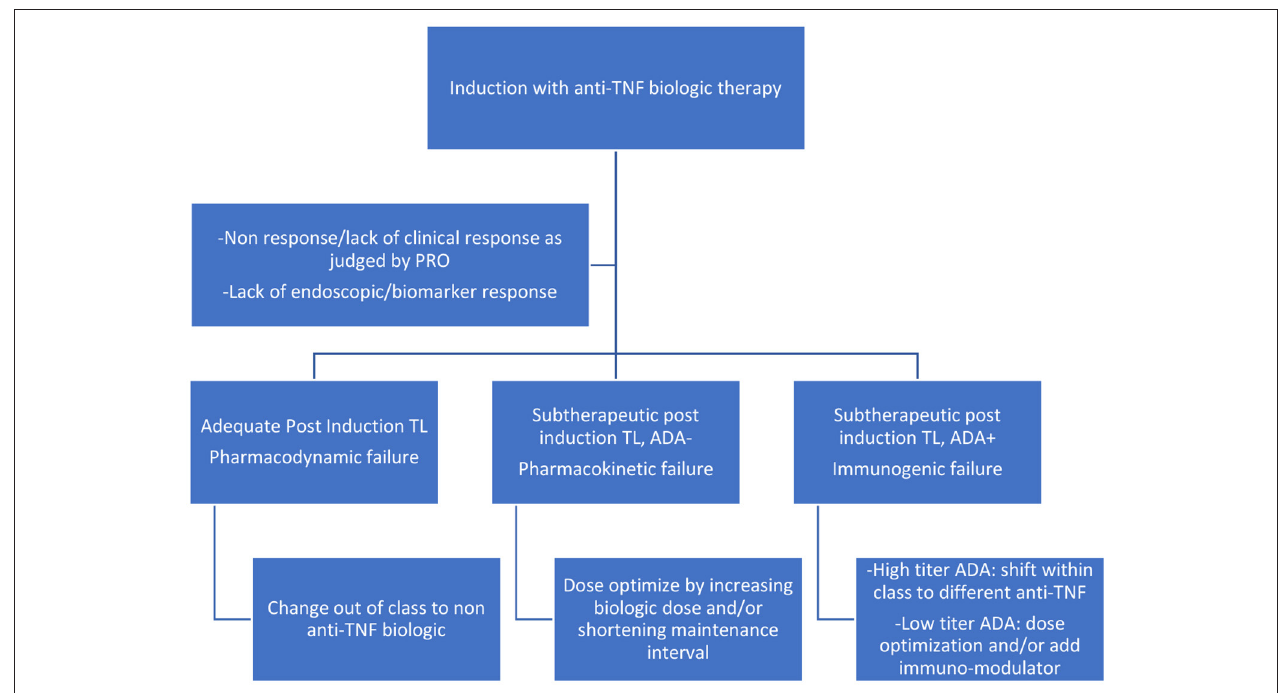
FIGURE 2 | Reactive drug monitoring scenarios during induction with anti-TNF